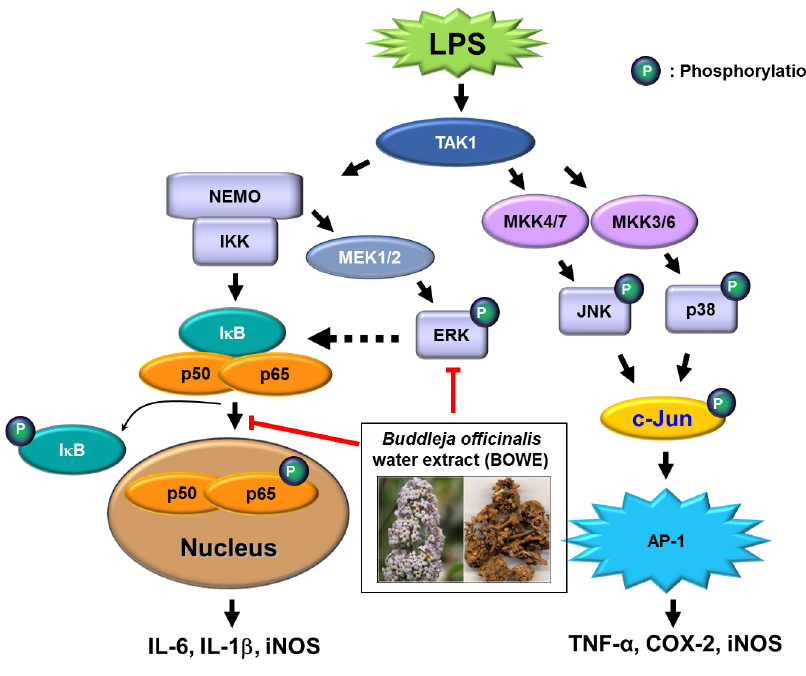
Figure 7. Suggested anti-inflammation mechanism of BOWE in LPS-treated BV-2 cells: In BV-2 cells treated with LPS, BOWE prevented the activation of ERK1/2 and NF- κ B, and subsequently attenuated the production of IL-6, IL-1 β , iNOS, and nitric oxide. BOWE did not have any effect on the activation of JNK, p38, and c-Jun and the production of TNF- α and COX-2. The negative regulation of ERK1/2 and NF- κ B activation is supposed to be the main mechanism of anti-inflammatory action of BOWE in BV-2